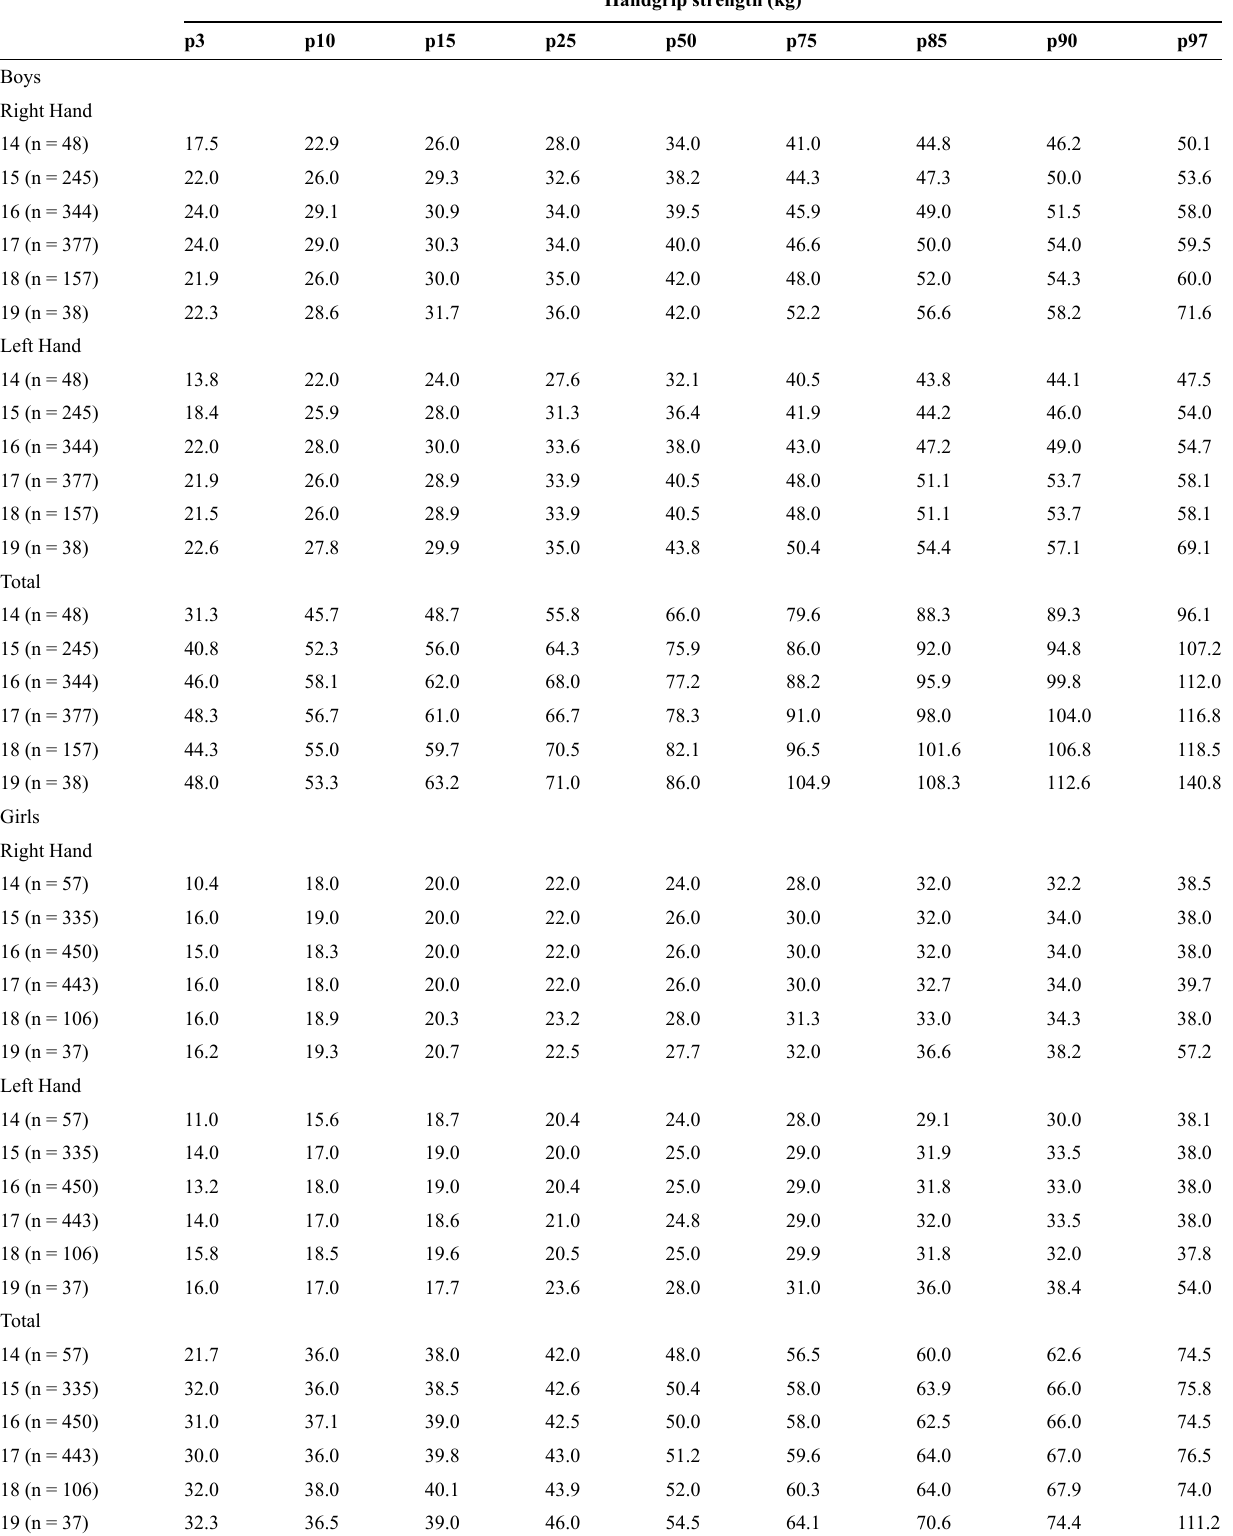
Handgrip strength (kg)